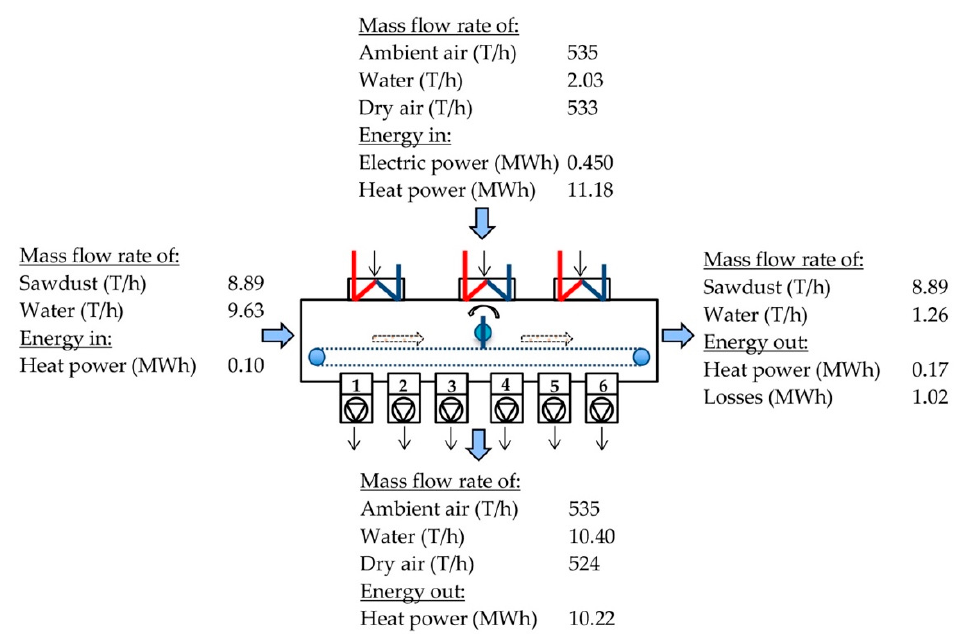
Figure 4. The energy and mass balance for the PMB.